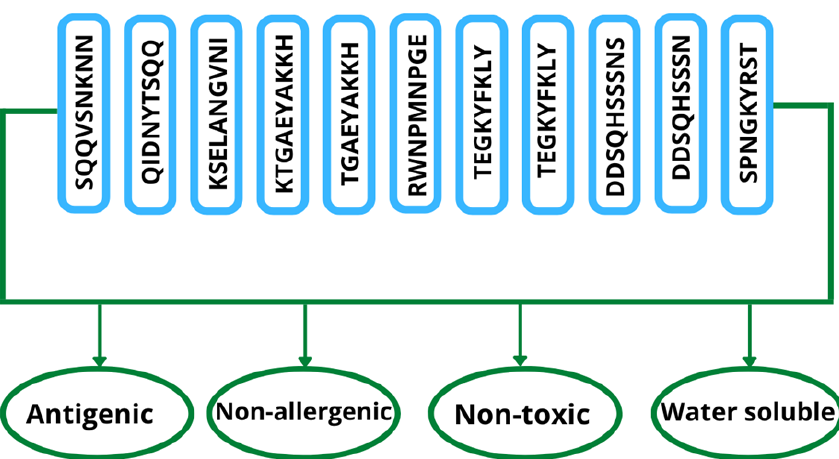
Figure 3. Number of 11 shortlisted epitopes that are non-toxic, non-allergenic, antigenic, and water- soluble.